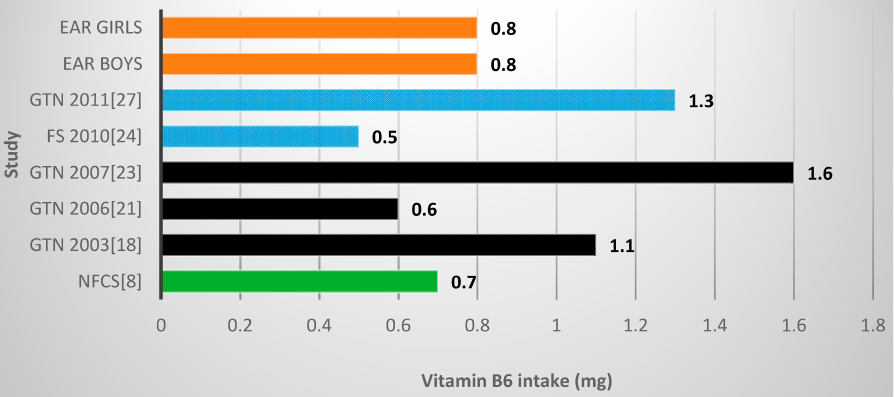
Figure 6. Mean vitamin B6 intake in studies on schoolchildren in South Africa between 2000 and 2015 with the blue bars representing two studies which included fortification values. EAR: estimated average intake; GTN: Gauteng; FS: Free State; NW: North West; NFCS: National Food Consumption Survey.